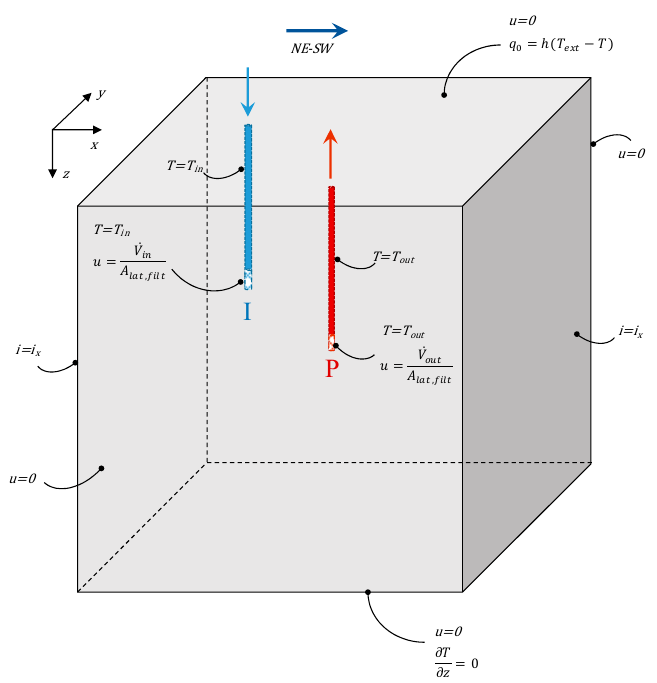
Figure 3. Sketch of boundary and domain initial conditions (for clarity the width of the wells is enlarged). P and I represent the production and injection wells, respectively. Table 4. Boundary and initial conditions.